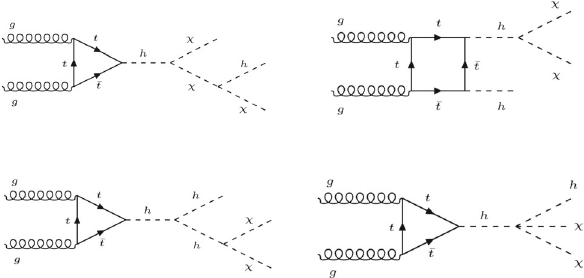
Fig. 1 The contribution to mono-Higgs + / E T final state from dimen- sion -4 operators